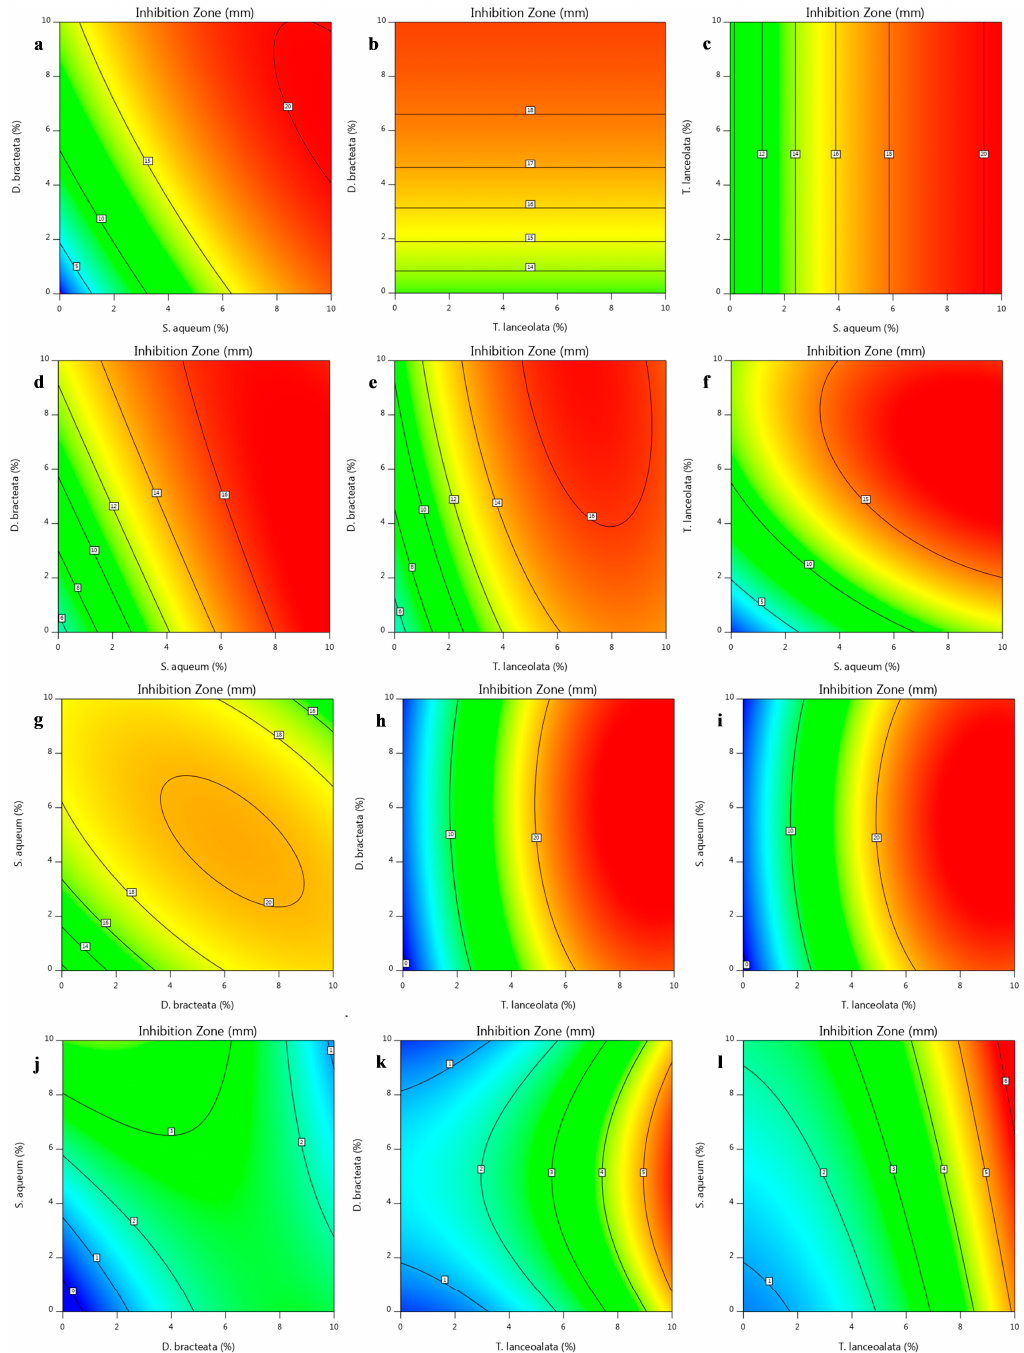
Figure 1. Contour plots for the inhibition zone of extract blends against Pseudomonas viridiflava ( a – c ), Bacillus subtilis ( d – f ), Rhodotorula diobovata ( g – i ) and Alternaria alternata ( j – l ) as a function of indepen- dent factors (Box–Behnken design).